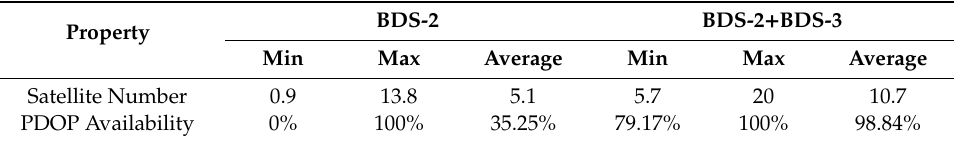
Table 1. Satellite number and PDOP availability (PODP < 6) for BDS-2 and BDS-2 + BDS-3 for an elevation angle mask of 10 ◦ on 1 January 2019.